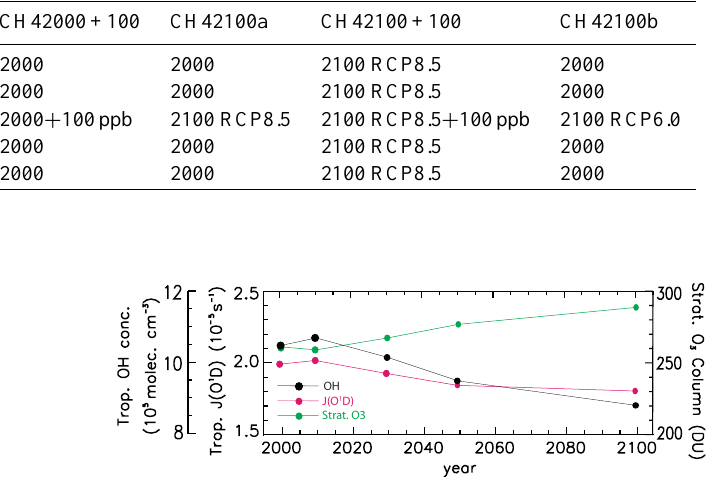
Fig. 5. Global tropospheric air mass-weighted OH concentration, volume-weighted tropospheric mean J (O 1 D) and stratospheric mean ozone column (above 200hPa) in the RCP6.0 simulation from the GISS-E2-R